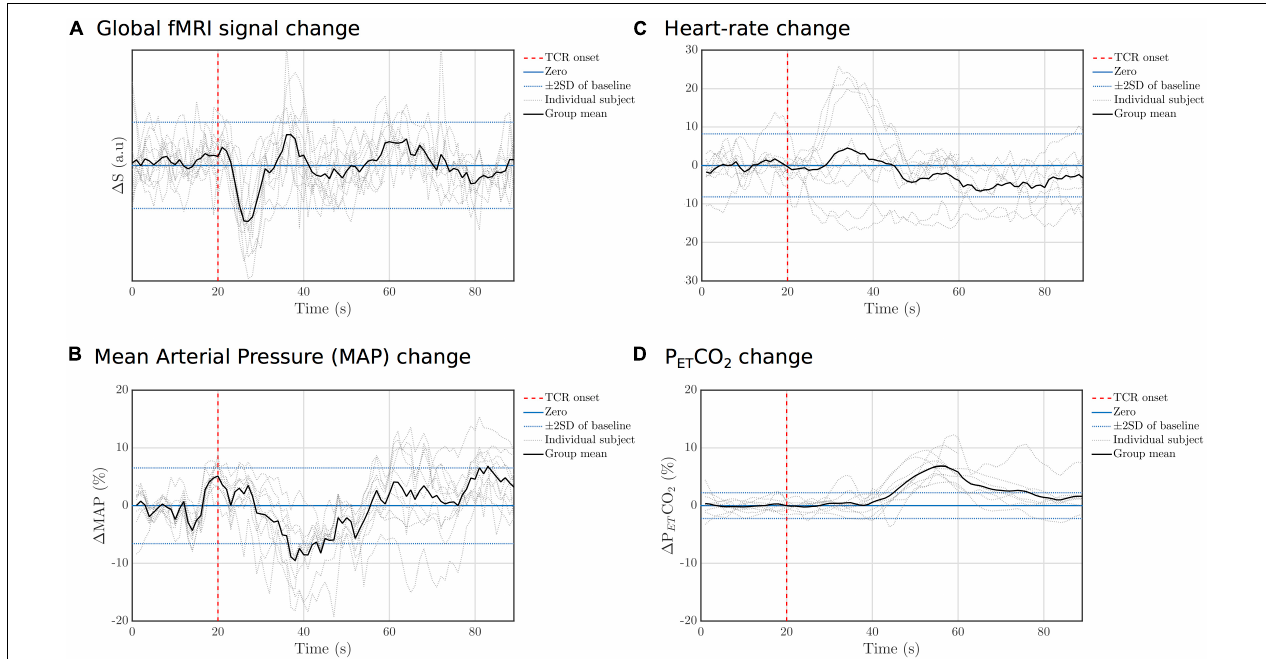
FIGURE 3 | Individual subject and group mean TCR evoked responses for (A) GS, (B) MAP, (C) HR, and (D) P ET CO 2 . For each variable the standard deviation (SD) of the fluctuations during the baseline peroid (concatenated across subjects) was calculated and then lines added to the graph to indicate ± 2 standard deviations.